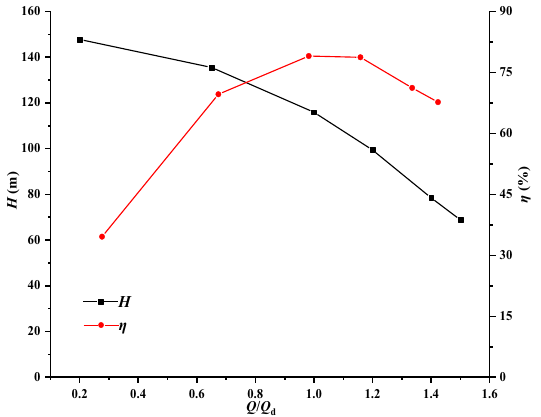
Figure 7. Hydraulic performance curve of multi-VLSFP.